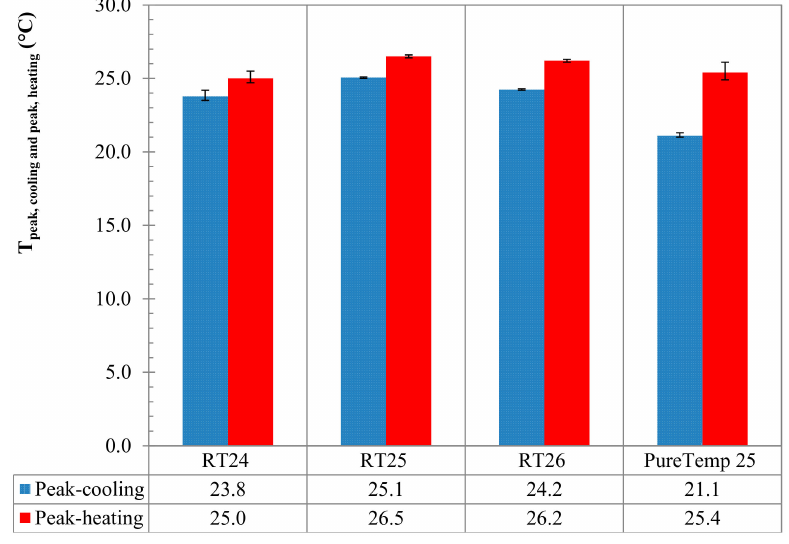
Figure 14. Comparison of the maximum peak temperatures ( ◦ C) of all samples in the melting / crystallization range.